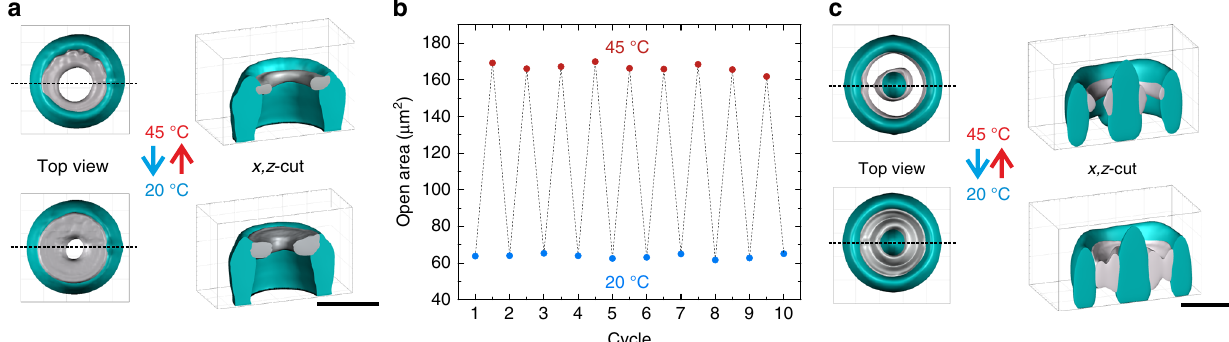
Fig. 2 Stimuli-responsive pNIPAM valves in PETA microchannels. a 3D reconstruction of experimental data recorded via confocal laser scanning microscopy. Two different color channels have been recorded, allowing to separate the fl uorescence from the PETA with the green fl uorescent DETC and that from pNIPAM with the red fl uorescent rhodamine dye. The corresponding iso-intensity surfaces are colored in turquoise and gray, respectively. Upon heating the sample to 45 °C, the opening in the middle widens. This process is reversible when cooling the sample back down. b Open area in the middle of the microchannel at 20 °C and 45 °C for multiple cycles of stimulation. We fi nd no signi fi cant deterioration. c Alternative design with an additional inner tube and two pNIPAM-tori. Complete closure of the microchannel can be achieved in a reversible manner. Scale bars are 30